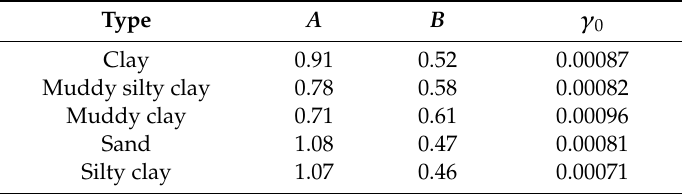
Table 1. Fitting parameters for di ff erent types of soil.